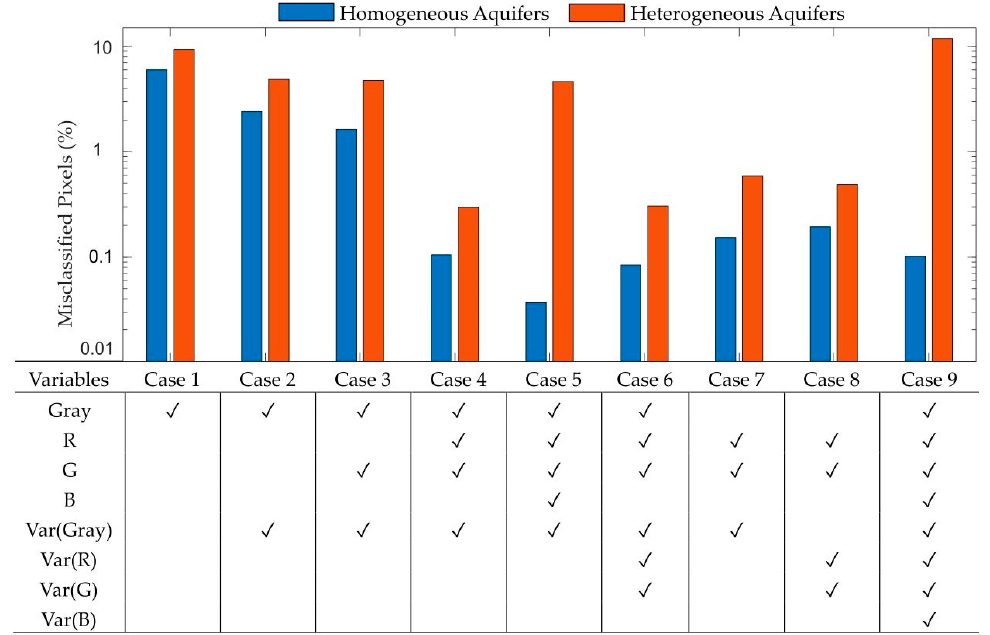
Figure 5. Percentage of misclassified pixels of homogeneous and heterogeneous aquifers by the pattern recognition ANNs trained on the nine different input variable subsets.